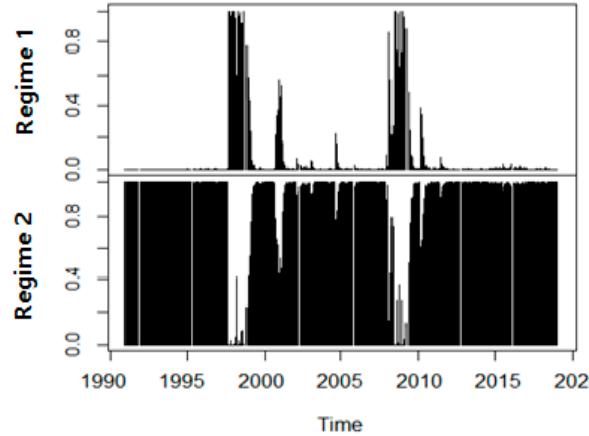
Figure 1. The filtered probabilities of belonging to regime 1 with high-volatility and regime 2 with low-volatility, estimated from the Markov-Regime Switching Model (MRSM) of the exchange rates along on oil prices, interest rates and trade balance of Korea. The upper plot shows regime 1, and the lower plot shows regime 2.